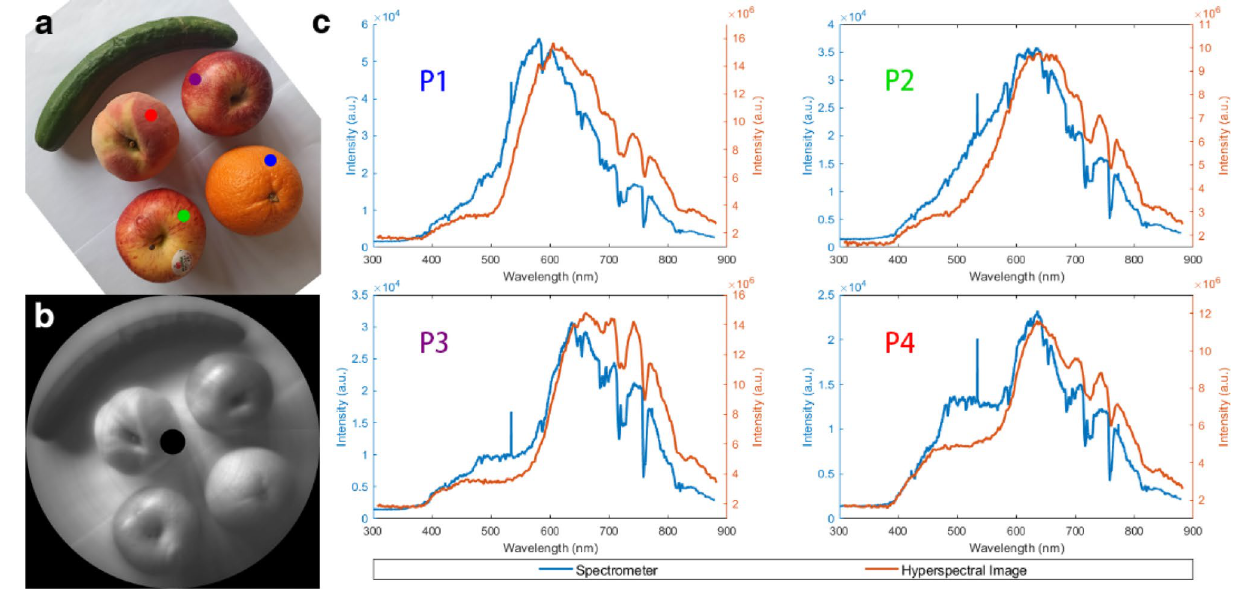
Figure 7. ( a ) Photo of fruits; ( b ) hyperspectral image; ( c ) spectra plot.